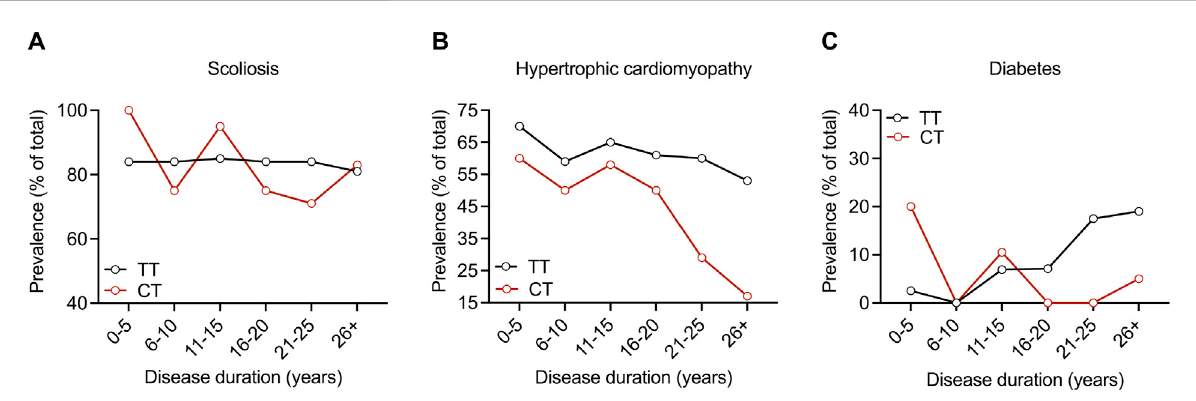
FIGURE 2 SIRT6 genotypedoesnotin fl uencetheprevalenceofscoliosis,hypertrophiccardiomyopathy,ordiabetesthroughoutdiseasedurationinFRDA. Prevalence of (A) scoliosis, (B) hypertrophic cardiomyopathy, and (C) diabetes plotted as % of the total over ranges of disease duration for both sub- cohorts. Proportions were compared at each disease duration range time point with Fisher ’ s exact test. All comparisons showed no statistical difference.